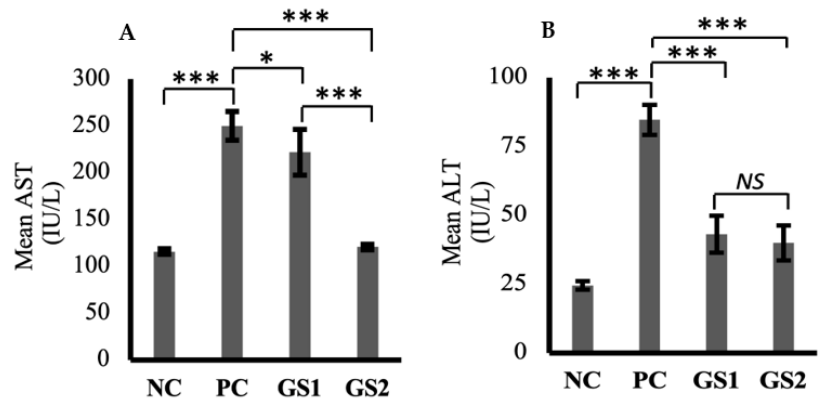
Figure 4. Mean values of aspartate aminotransferase (AST, IU/L) ( A ) and alanine aminotransferase (ALT, IU/L) ( B ) in different treatment groups. Negative control (NC), positive control (PC), Gymnema sylvestre 250 mg (GS1), Gymnema sylvestre 500 mg (GS2). NS : non-significant, ( * ): p ≥ 0.05, ( *** ): p ≥ 0.001.